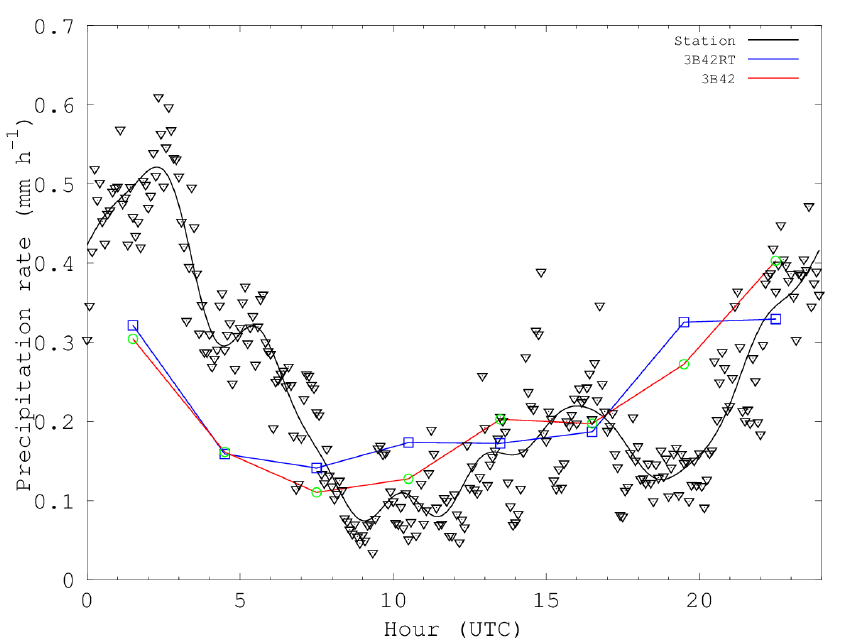
Figure 3. Mean precipitation diurnal cycle, 2013–2014, averaged across 3 stations in Nepal (5-minute values and a Fourier series smoothed fit are shown) and for satellite products with 3-hour resolution subsampled at the same grid points. Nepal Standard Time is 5:45 hours ahead of Universal Time.